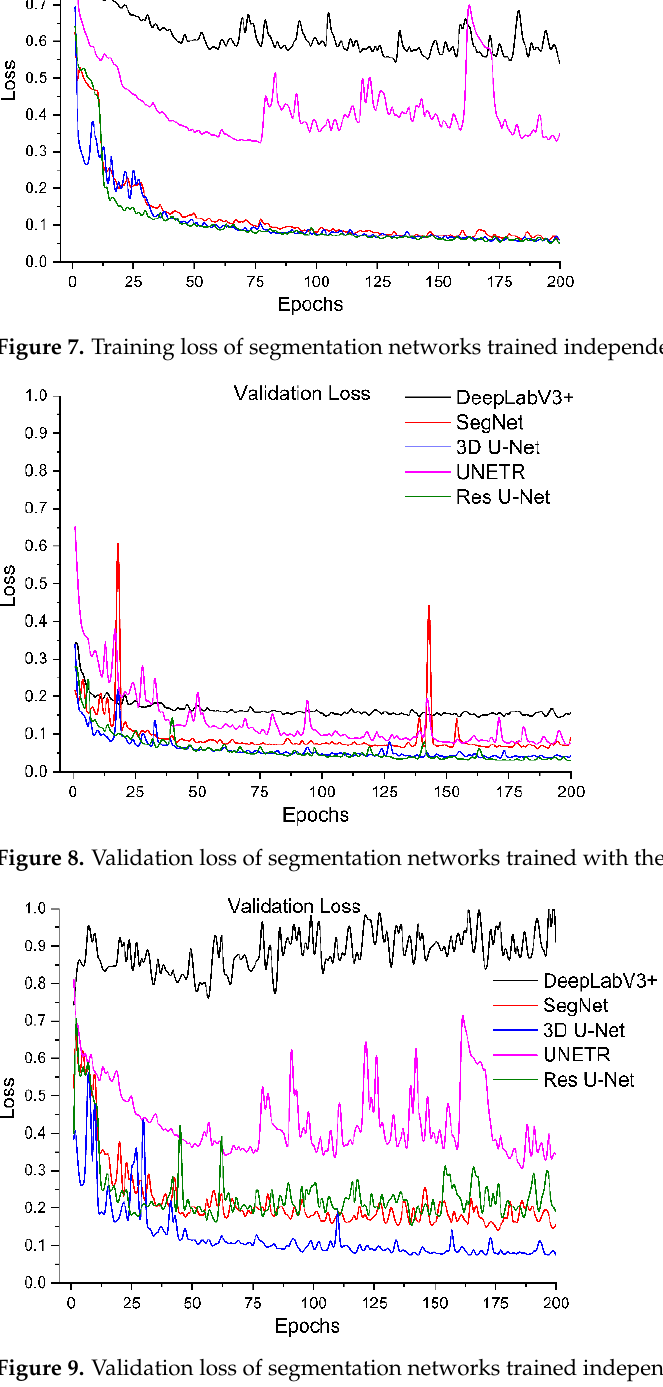
Figure 9. Validation loss of segmentation networks trained independently.